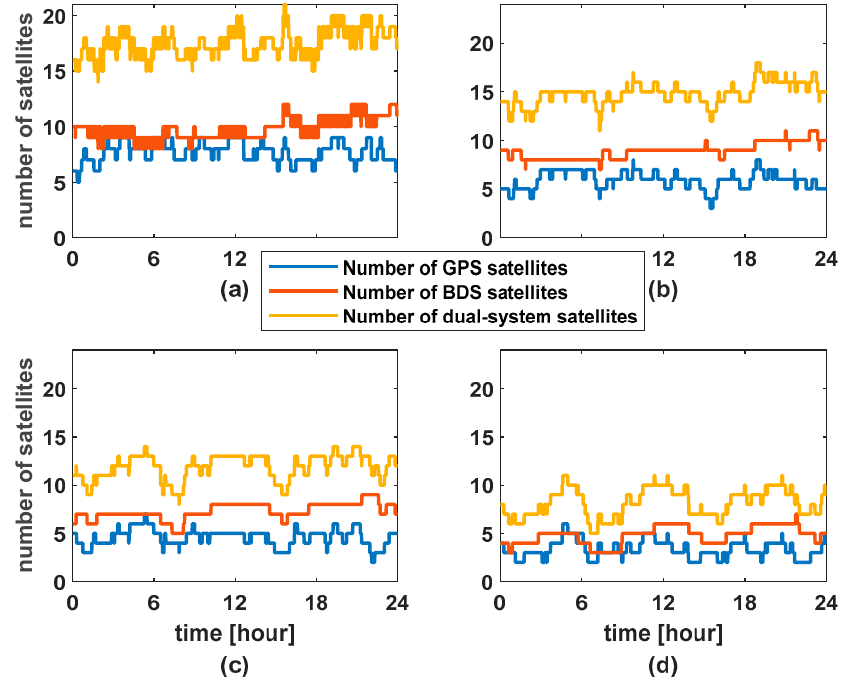
Figure 3. Number of GPS and BDS satellites at different cut-off elevation angles. ( a ) 15 degrees. ( b ) 25 degrees. ( c ) 35 degrees. ( d ) 45 degrees.